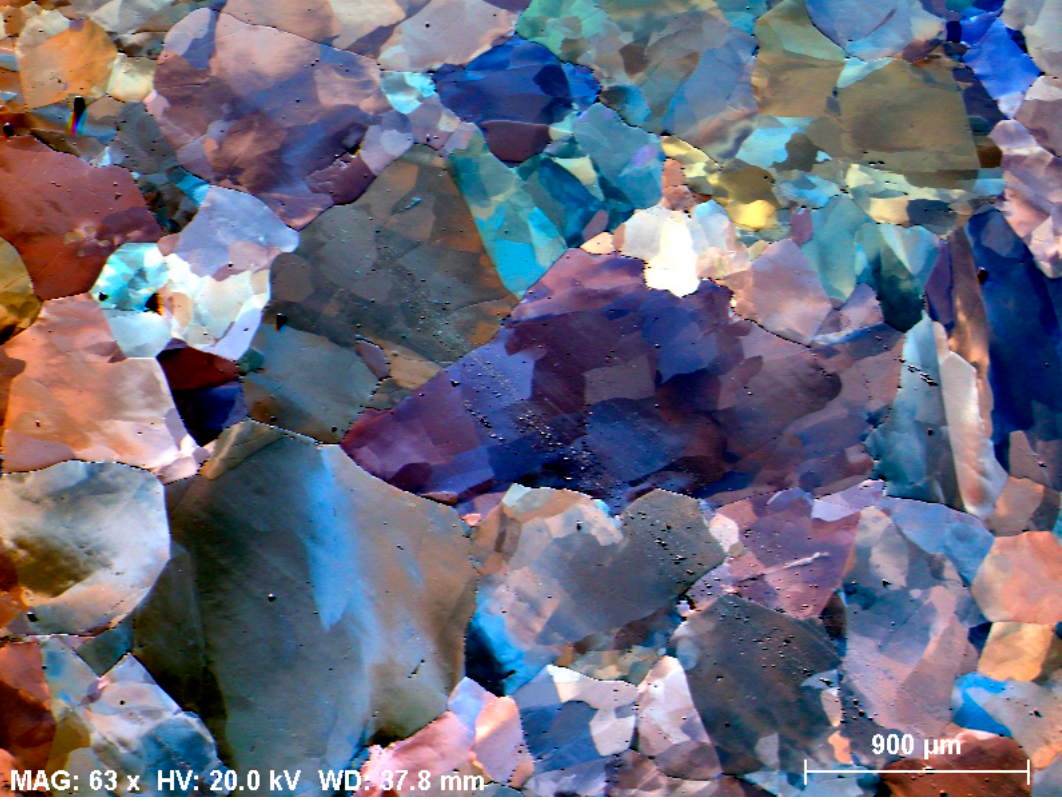
Figure 12. SEM forescattered image showing low-angle tilting of sub-grains due to deformation in the hydrothermal quartz from Kyshtym (Ky-175).